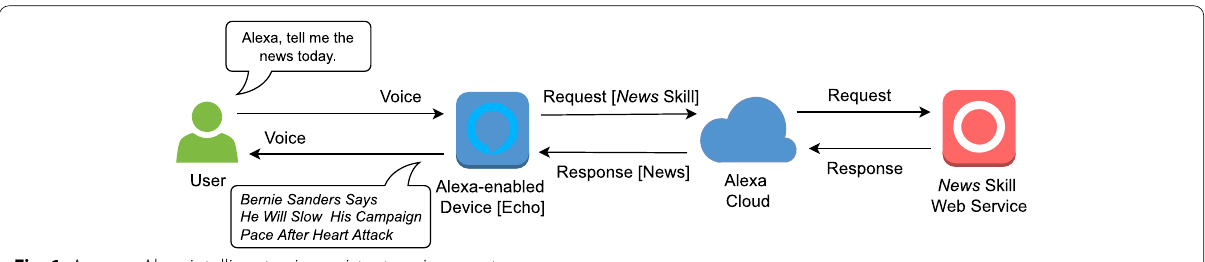
Fig. 1 Amazon Alexa intelligent voice assistant